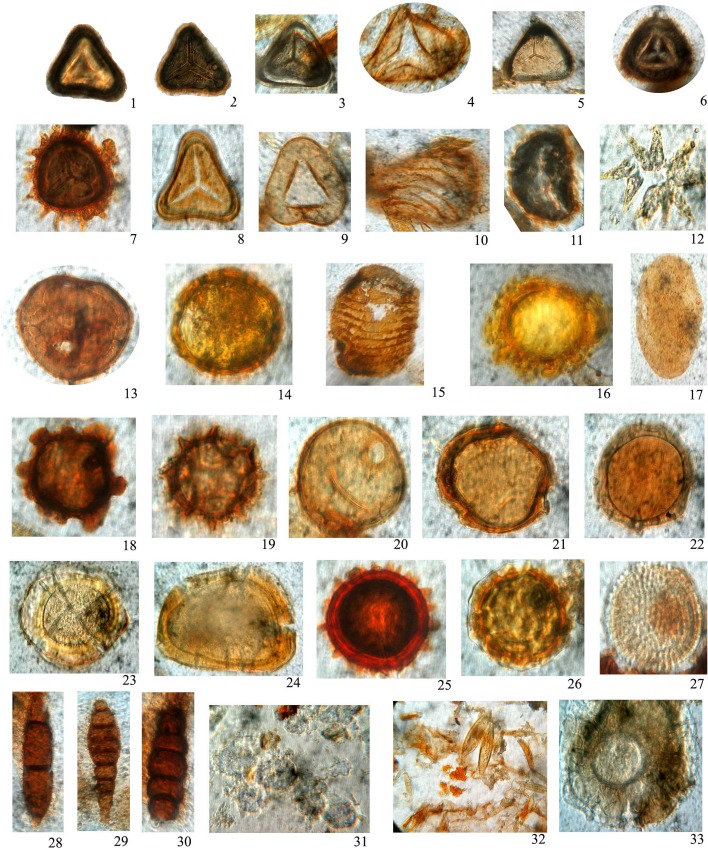
Palynological assemblage of Puvathur.(All photomicrographs magnified ca x 500 unless otherwise specified and ca x 1000 for fungal remains). 1, 2. Pteridacidites sp. (Pteridaceae). 3, 5. Cyathidites sp. (Cyatheaceae). 4, 6. Ceratopteris thalictroides (Parkeriaceae). 7. Anemia phyllitides (Anemiaceae). 8. Cyathea sp. (Cyatheaceae). 9. Trilete fern spore. 10. Schizaeisporites multistriatus (Schizaeceae). 11. Polypodium vulgare (Polypodiaceae). 12. Pediastrum sp. 13, 14, 22. Meliaceae pollen. 15. Acanthaceae pollen. 16, 25, 26. Malvaceae pollen. 17.? Acanthaceae pollen. 18. Euphorbiaceae pollen. 19. Vernonia travancorica (Asteraceae). 20, 21. Cullenia exarillata (Bombacaceae). 23, 24. Unidentified pollen. 27. Croton sp. (Euphorbiaceae). 28, 30. Multicellaesporites sp (Fungal spore). 29. Pluricellaesporites sp (Fungal spore). 31. Botryococcus sp. 32. Sponge spicules. 33. Thecamoeba.